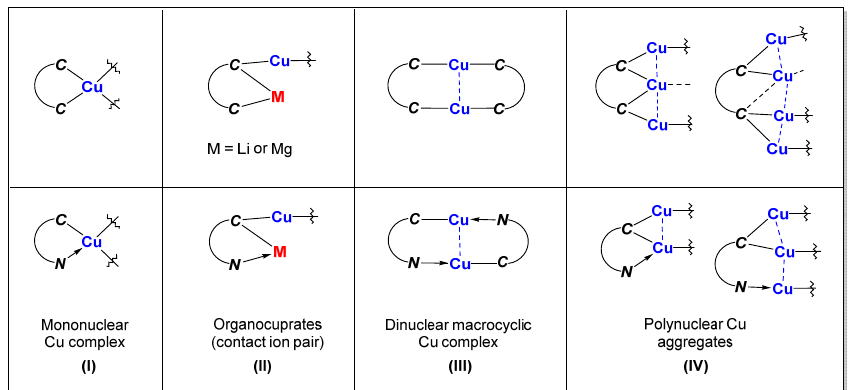
Scheme 1. Fragments in the molecular structures with characteristic connectivity. The lines do not necessarily represent 2c-2e or 3c-2e bonds.